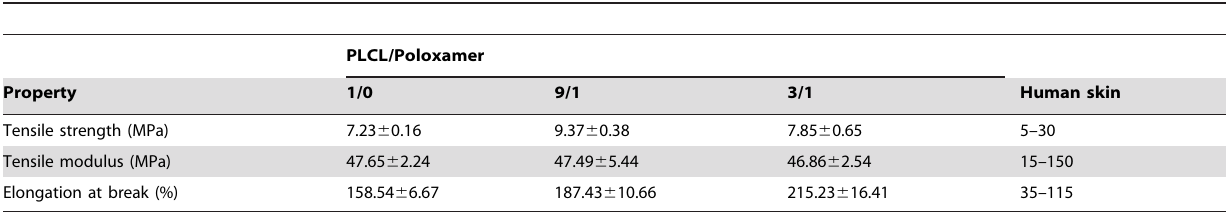
Table 2. Mechanical properties of PLCL and PLCL/Poloxamer nanofibers at various blend ratios compared with human skin.